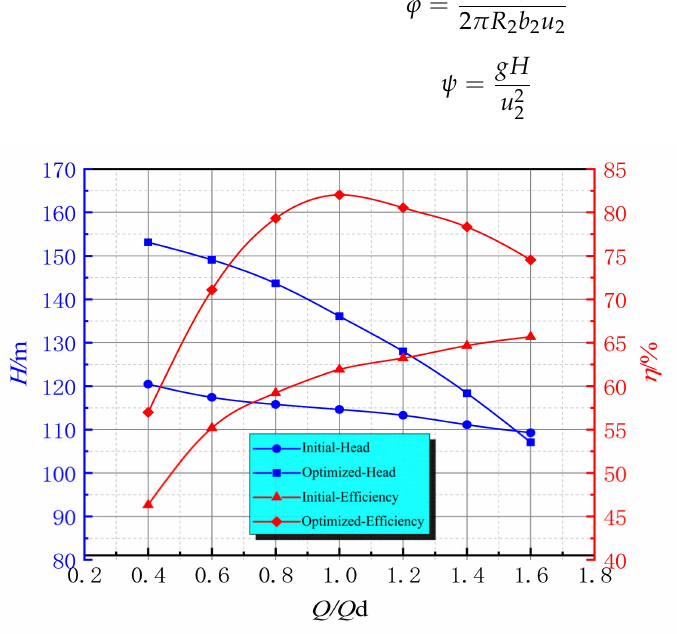
Figure 9. Optimization effect of the numerical simulation on the pump